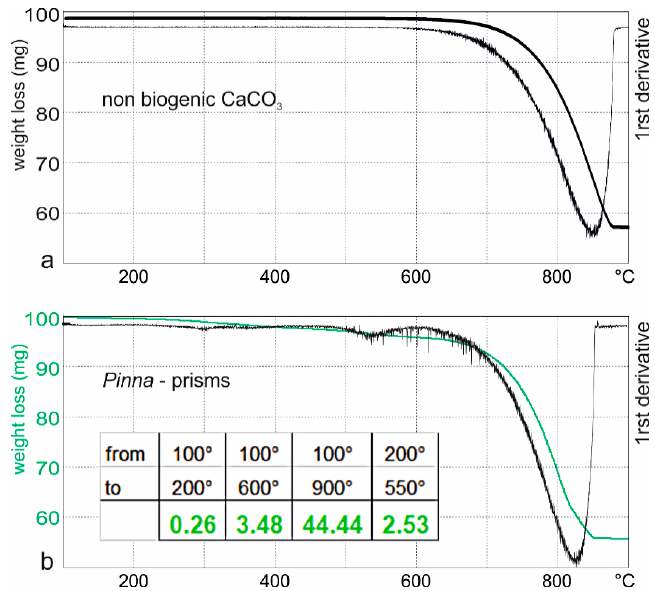
Figure 5. Thermogram and first derivative of ( a ) non biogenic CaCO 3 and ( b ) the prismatic layer of Pinna ; insert: Weight loss (in %).